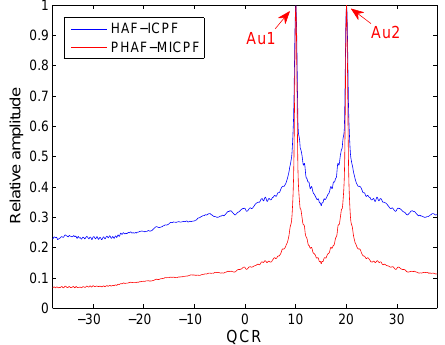
Figure 4. Cross-term suppression of